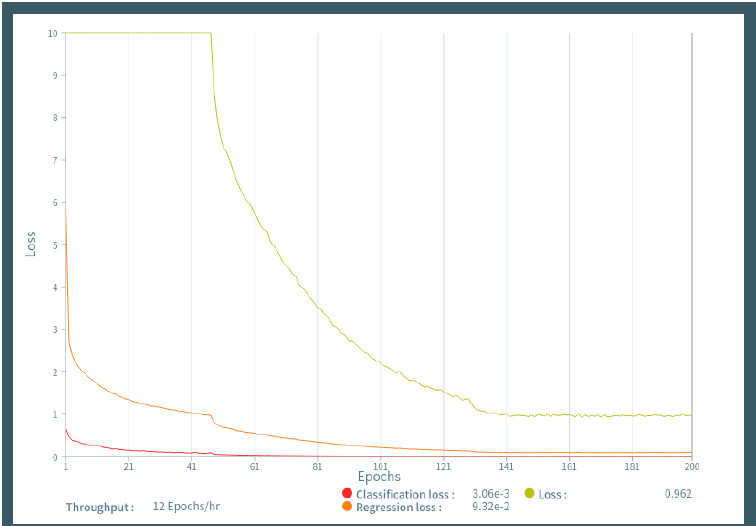
Figure 3. Figure 3 shows the learning curves generated by epochs and data loss, demonstrating that learning above 150 epochs resulted in low data